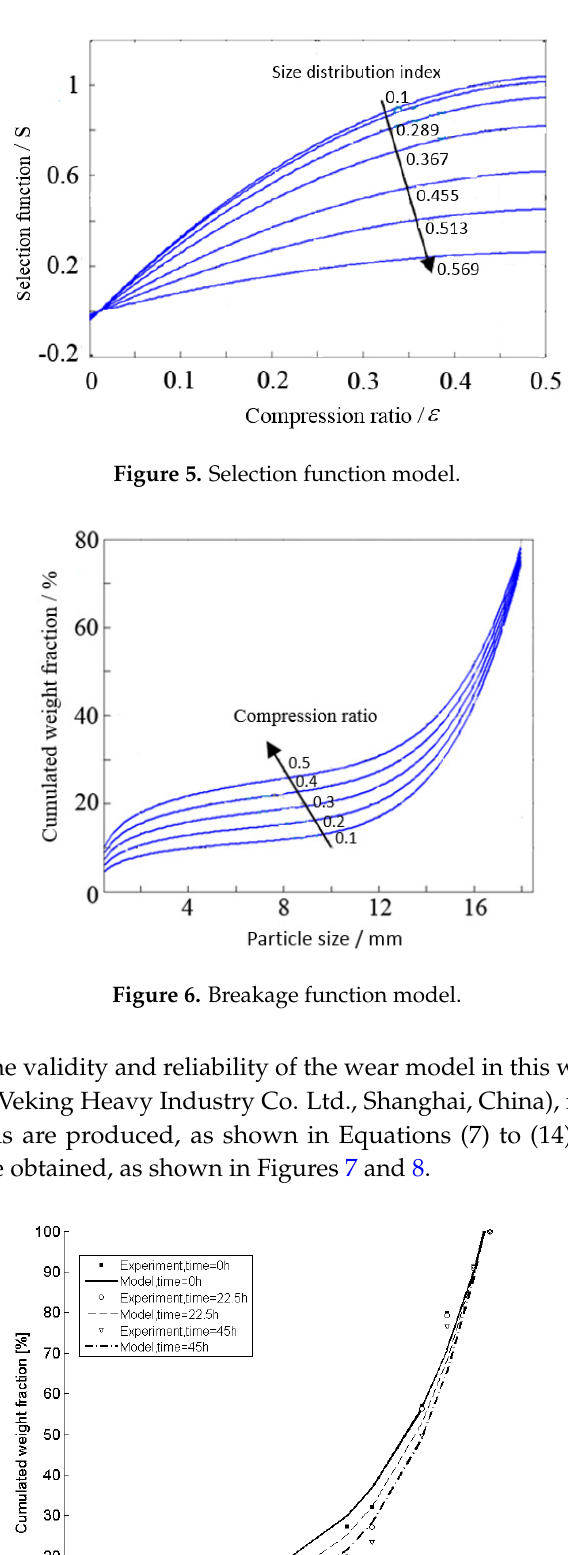
Figure 8. Worn liner causes the flakiness curve to change over time. The prediction data of product size distribution are obtained by Equations (7) to (14), and the measured data are obtained from field test, as shown in Table 2. Table 2. Comparison between measured and predicted results of the particle size distribution (PSD). Size (mm)